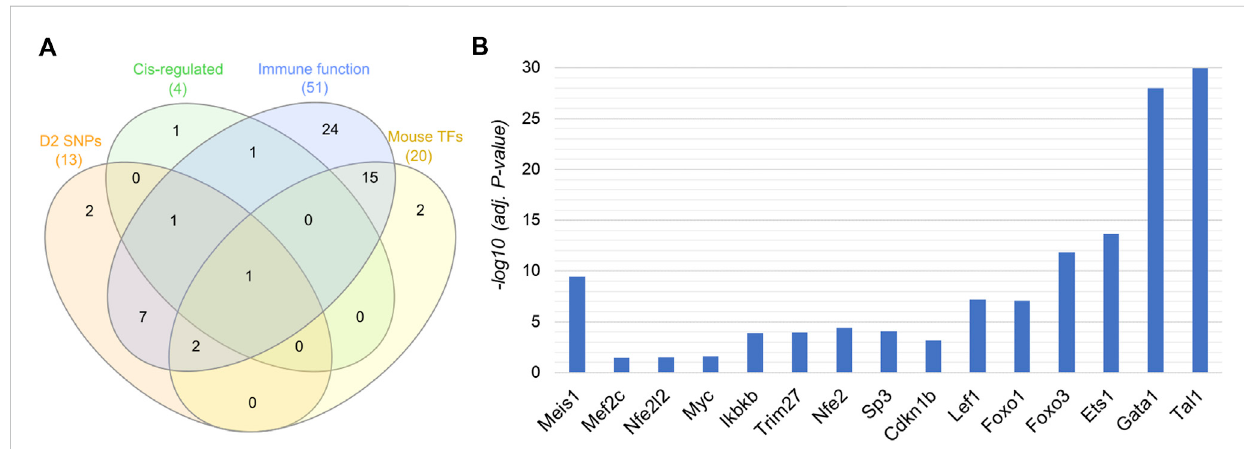
FIGURE 5 Genes shared across different functional categories. (A) Genes with a node degree of at least 5 ( n = 61) are shown in the Venn diagram. Genes were selected based on the following categories: harbouring coding SNPs, cis -regulated in BXD strains, acting as TFs, and associated with immune/ hematopoieticsystemrelatedfunctionorphenotype. (B) Statisticalsigni fi canceofselectedgenesinvolvedinimmunefunctionsalongwithatleastoneof theother threefunctional categories (shown intheVenn diagram). − log10(adj. p -value) in y -axis represents thesigni fi cant differential expressionof the genes between mouse AML and normal control. A − log10 (adj. p -value) of 1.3 is equal to an actual adjusted p -value of